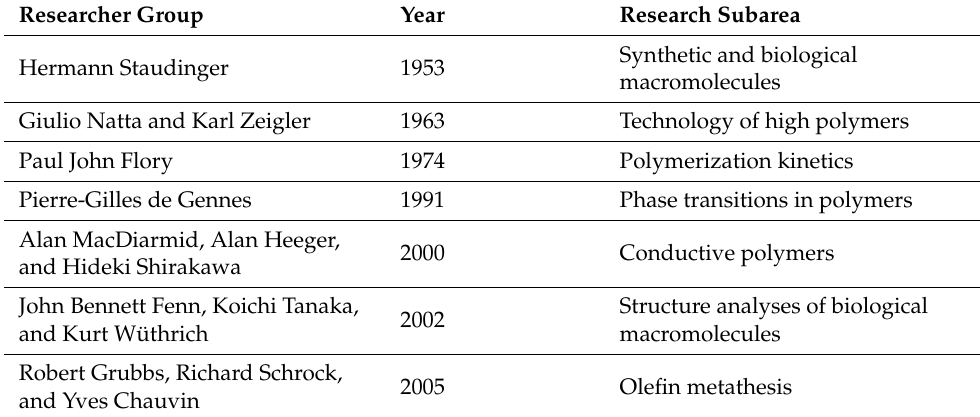
Table 3. Nobel Prize awarded for research in the field of polymer